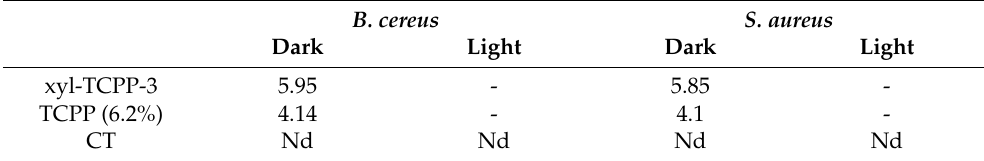
Table 2. Mean values of log (CFU · mL − 1 ) maintained in the dark and after irradiation. CT: control; xylan-hydrogel without TCPP [21] ‘’-” No surviving bacteria could be detected. Nd: no reduction in cell viability was observed .